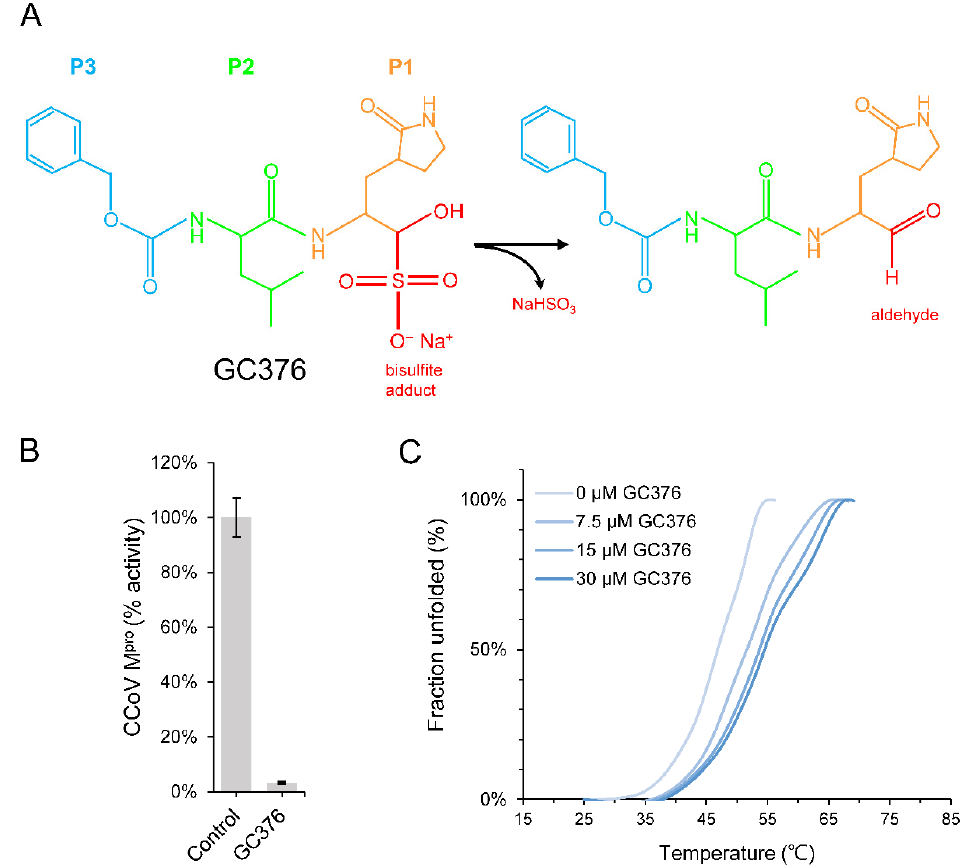
Figure 1. Functional characterization of the effects of GC376 on CCoV M pro : ( A ) The chemical structure of GC376 (left) and its aldehyde form (right); ( B ) in vitro enzyme activity assay of CCoV M pro in the absence or presence of GC376; ( C ) dose-dependent stabilization effects of GC376 (0, 7.5, 15, and 30 µ M) on the thermal stability of CCoV M pro